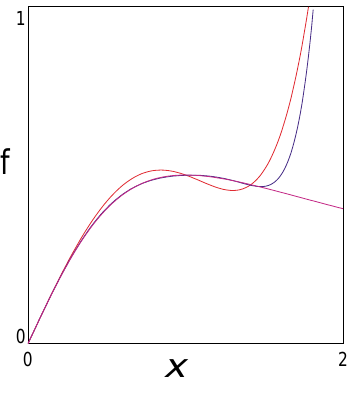
FIG. 10. (Color) Polynomial approximation of the space charge force F (cid:2) x (cid:3) (cid:1) z a 2 1 f (cid:2) x (cid:1) a (cid:3) , where f (cid:2) x (cid:3) (cid:1) x (cid:1)(cid:2) 1 1 x 2 (cid:3) . Func- tion f (cid:2) x (cid:3) (violet line), approximation of order 5 f 5 (cid:2) x (cid:3) (cid:1) x 2 2 x 3 1 1 x 5 (red line), approximation of order 9 f 9 (cid:2) x (cid:3) (cid:1) x 2 3 6 0.9268 x 3 1 0.6313 x 5 2 0.2430 x 7 1 0.0378 x 9 (blue line)